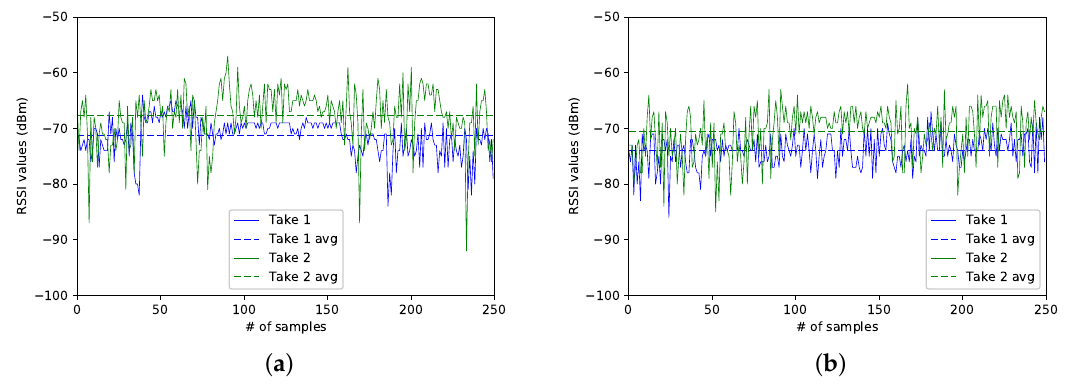
Figure 7. Sector 15: Comparison of the RSSI from different BLE4.0 beacons for Tx = 0x04. ( a ) for Be07; ( b ) for